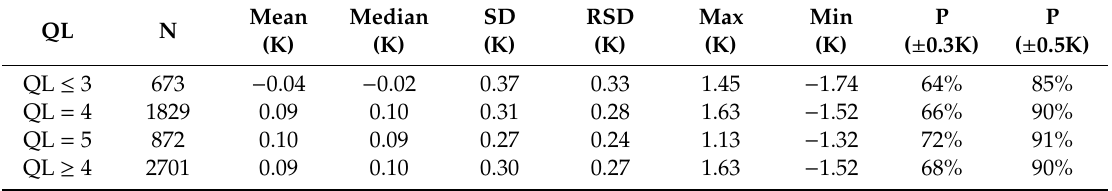
Table 4. Statistics of SST di ff erence of the matchups for di ff erent ISAR